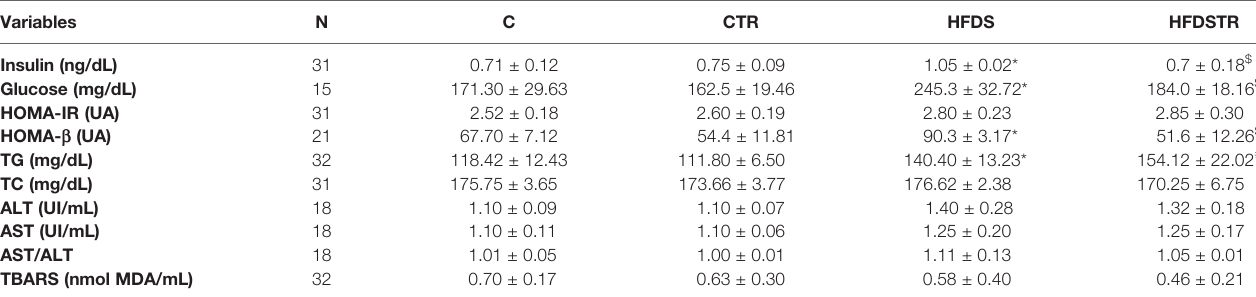
TABLE 2 | Serum biochemical pro fi le following the eight-week intervention in the C, CTR, HFDS and HFDSTR groups. Variables N